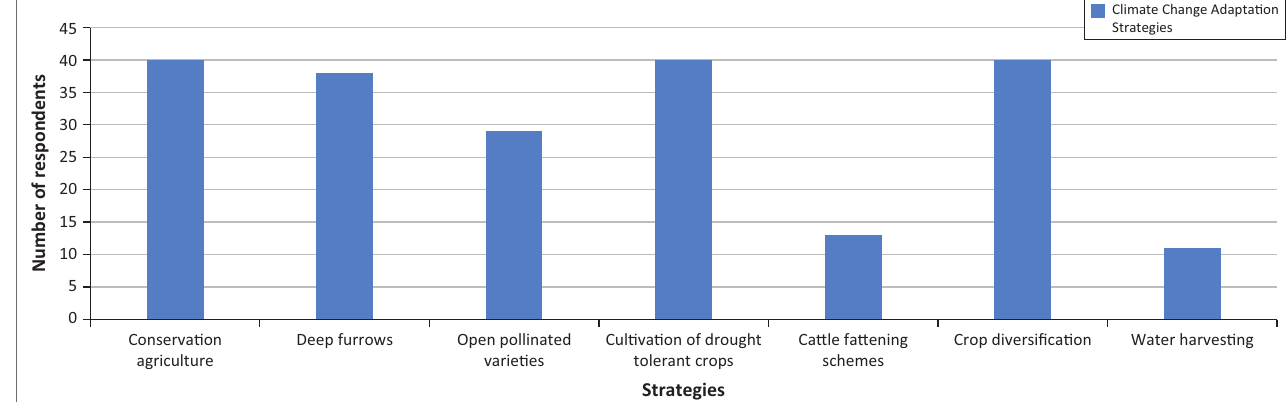
FIGURE 8: Adaptation strategies in Chilonga